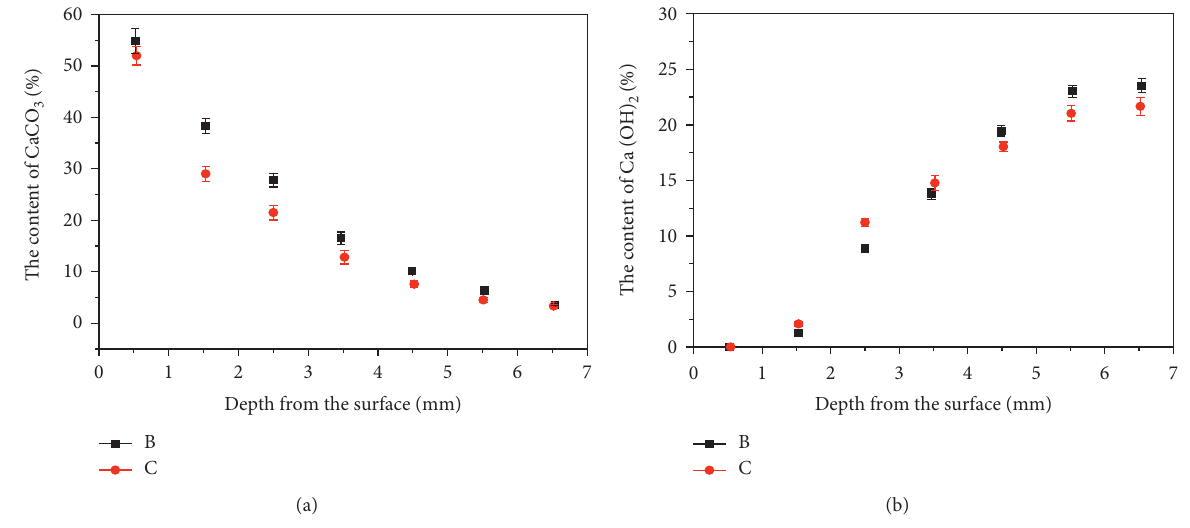
Figure 9: Content of CaCO 3 (a) and Ca(OH) 2 (b) at different depths of